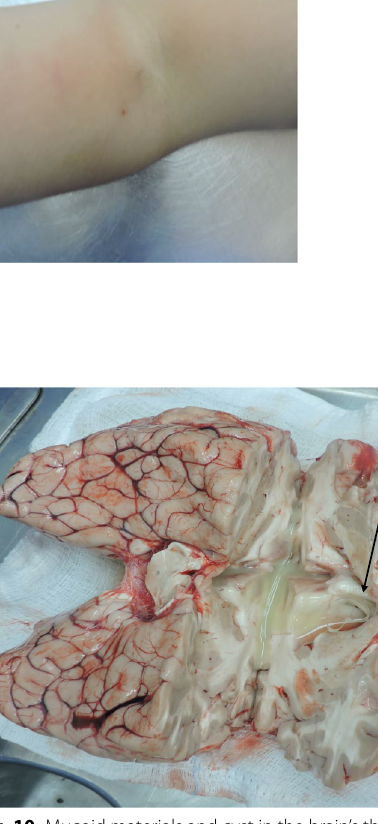
Fig. 10 Mucoid materials and cyst in the brain’s third